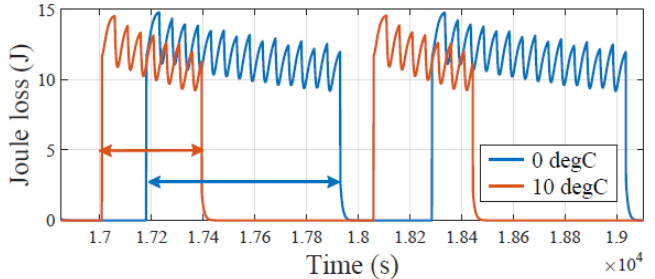
Figure 9. Energy (J) losses at 10 ◦ C (red) and 0 ◦ C (blue) on the NMC battery cell, for a couple of periods of the bi-directional current preheat